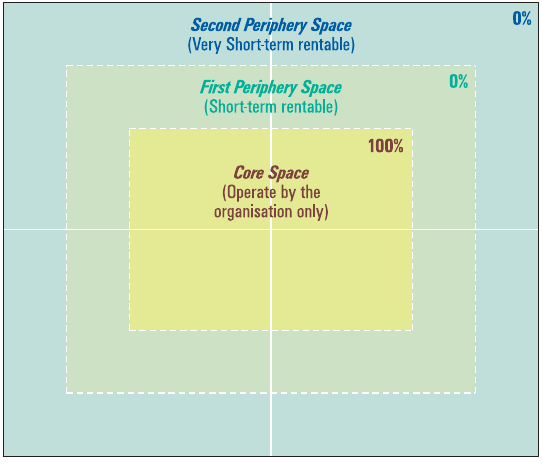
Figure 8. Portfolio fl exibility of traditional layout offi